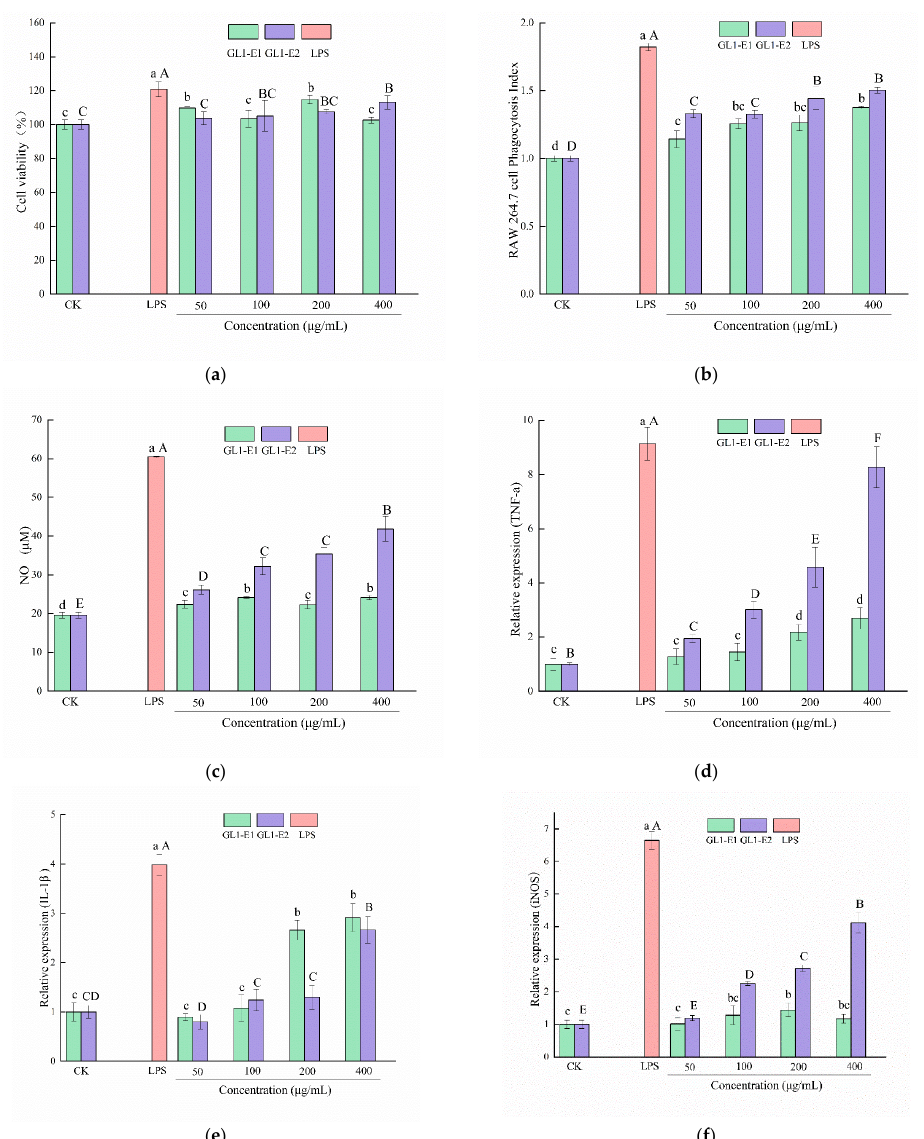
Figure 6. Effects of GL1-E1 and GL1-E2 on RAW264.7 cells in vitro. Cell viability ( a ), phagocytosis index ( b ), NO production ( c ), TNF- α ( d ), IL-1 β ( e ), and iNOS ( f ). Lowercase letters (a–d) and uppercase letters (A–F) indicated significant differences among different concentrations ( p < 0.05) within the GL1-E1 and GL1-E2 groups,